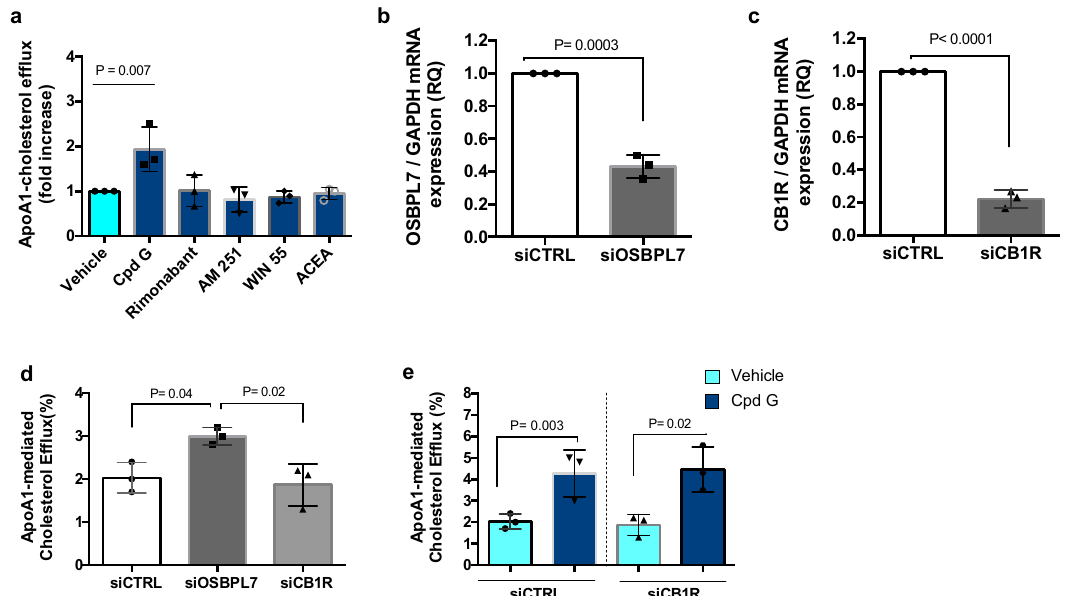
Fig. 4 Effects of OSBPL7 and CB1R siRNA and CB1R agonists on ABCA1-mediated cholesterol ef fl ux. a Effects Cpd G and several CB1R-targeted compounds on apoAI-mediated cholesterol ef fl ux in THP1 cells. All compounds were used at a concentration of 5 µ M. Data expressed as mean ± SD ( n = 3). All treatments were compared to vehicle using one-way ANOVA, F(5, 12) = 6.5), followed by Dunnett ’ s test. P = 0.01 for Cpd G; P > 0.05 for the other Cpds. b , c Repression of OSBPL7 or CB1R mRNA following transfection of speci fi c siRNAs in differentiated THP1 macrophages. Data expressed as mean ± SD ( n = 3). Groups were compared using a double-tailed t -test. RNAi reduced OSBPL7 expression by ~60% (t(4) = 13.7, P = 0.0002) and CB1R expression by ~80% (t(4) = 26, P < 0.0001). d Effects of siRNAs targeting OSBPL7 and CB1R on apoAI-mediated cholesterol ef fl ux from THP1 macrophages. Data expressed as mean ± SD ( n = 3). Treatments were compared one to another using unpaired one-way ANOVA, F(2, 6) = 8.3, P = 0.019, followed by Tukey ’ s test: siRNA knockdown of OSBPL7 expression signi fi cantly increased cholesterol ef fl ux when compared to non-targeting control ( P = 0.04) and to siCB1R ( P = 0.02), while knockdown of CB1R had no effect ( P = 0.85). e Effect of Cpd G (5 µ M) on apoAI-mediated cholesterol ef fl ux from macrophages in which CB1R expression was repressed by siRNA. Data expressed as mean ± SD ( n = 3). Groups were compared to each other using unpaired one-way ANOVA, F(3, 8) = 8.7), followed by Tukey ’ s test. When comparing Vehicle vs Cpd G: P = 0.04 in siCTRL, and P = 0.02 in siCB1R cells. Knockdown of